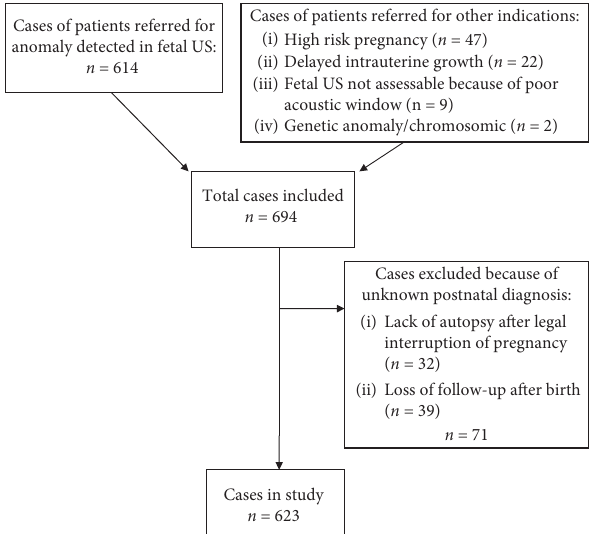
Figure 1: Flow diagram. Cases of patients referred for prenatal diagnosis by magnetic resonance imaging between January 2007 and December 2018. Table 2: Indications of the 623 cases with a previous ultrasound study referred for fetal MRI between January 2007 and December 2018.